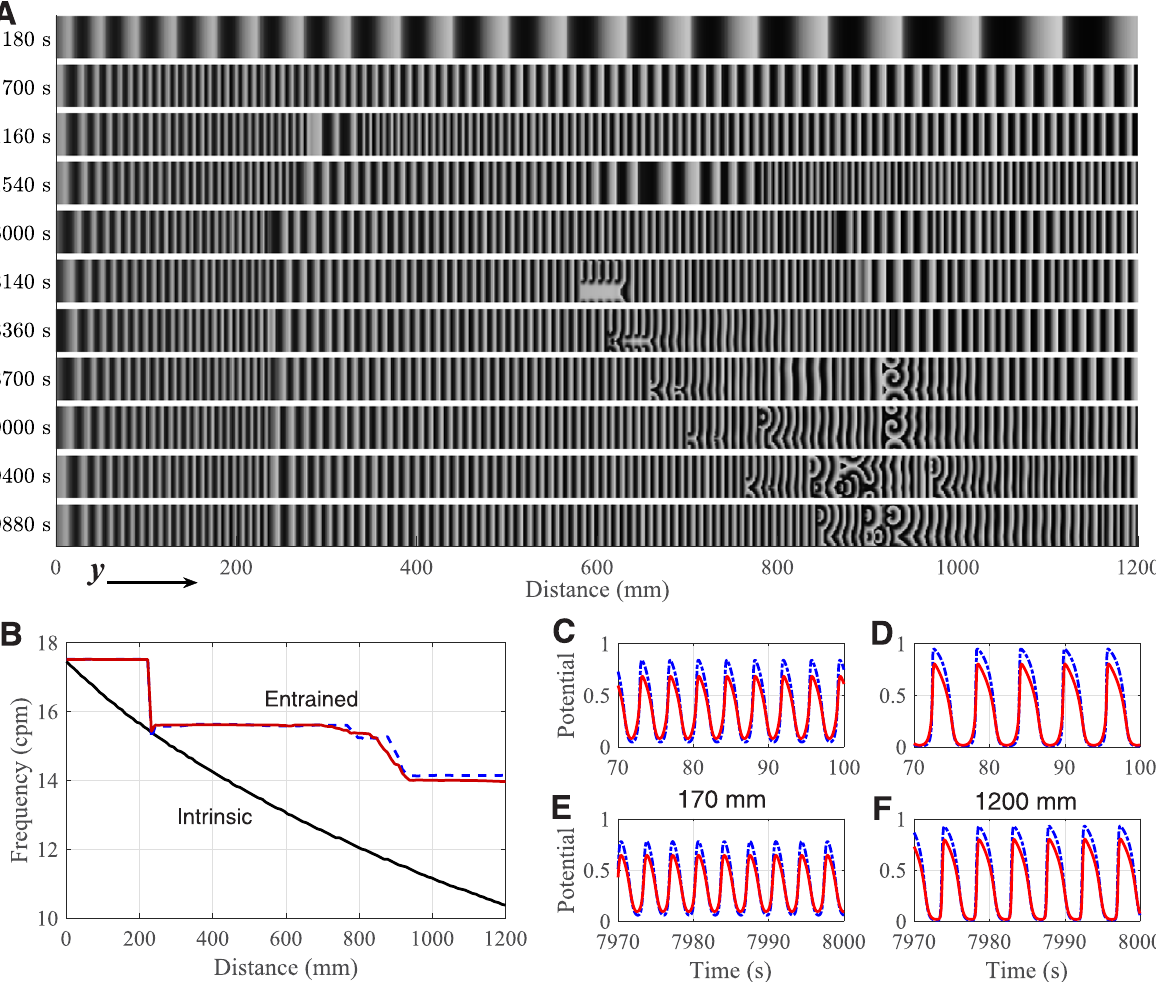
Fig 9. 3D simulation of intestine. A. Snapshots of spatial distributions of the transmembrane potential u I in the ICC layer at different time moments t . Brighter areas correspond to higher potential. From top to bottom: (1–5) formation of constant frequency plateaus, (6–11) onset and evolution of intestinal dysrhythmia pattern due to temporary conduction block induced at t = 8100 s to both ICC and SMC layers. B. Distributions of the intrinsic frequency ( D I = D M = 0, solid black line), entrained frequency of oscillators at t = 8000 s (solid red line), and at the end of the simulation ( t = 11600 s, dashed blue line). C–D. u I (red solid lines) and u M (blue dot-dashed lines) action potentials at the distance of 170 mm (C) and 1200 mm (D) at the beginning of the simulation ( t ’ 100 s). E–F. The same as in panels C and D, but at t ’ 8000 s.